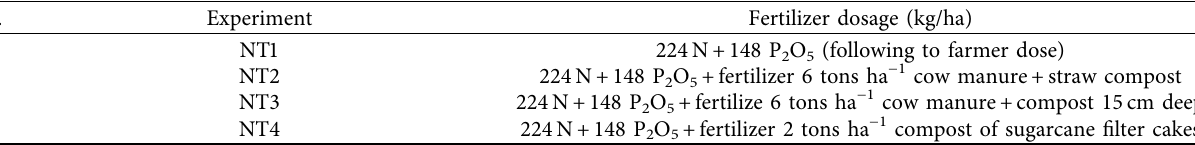
Table 1: Fertilizer dosage of diferent treatments in the Cho Moi district.